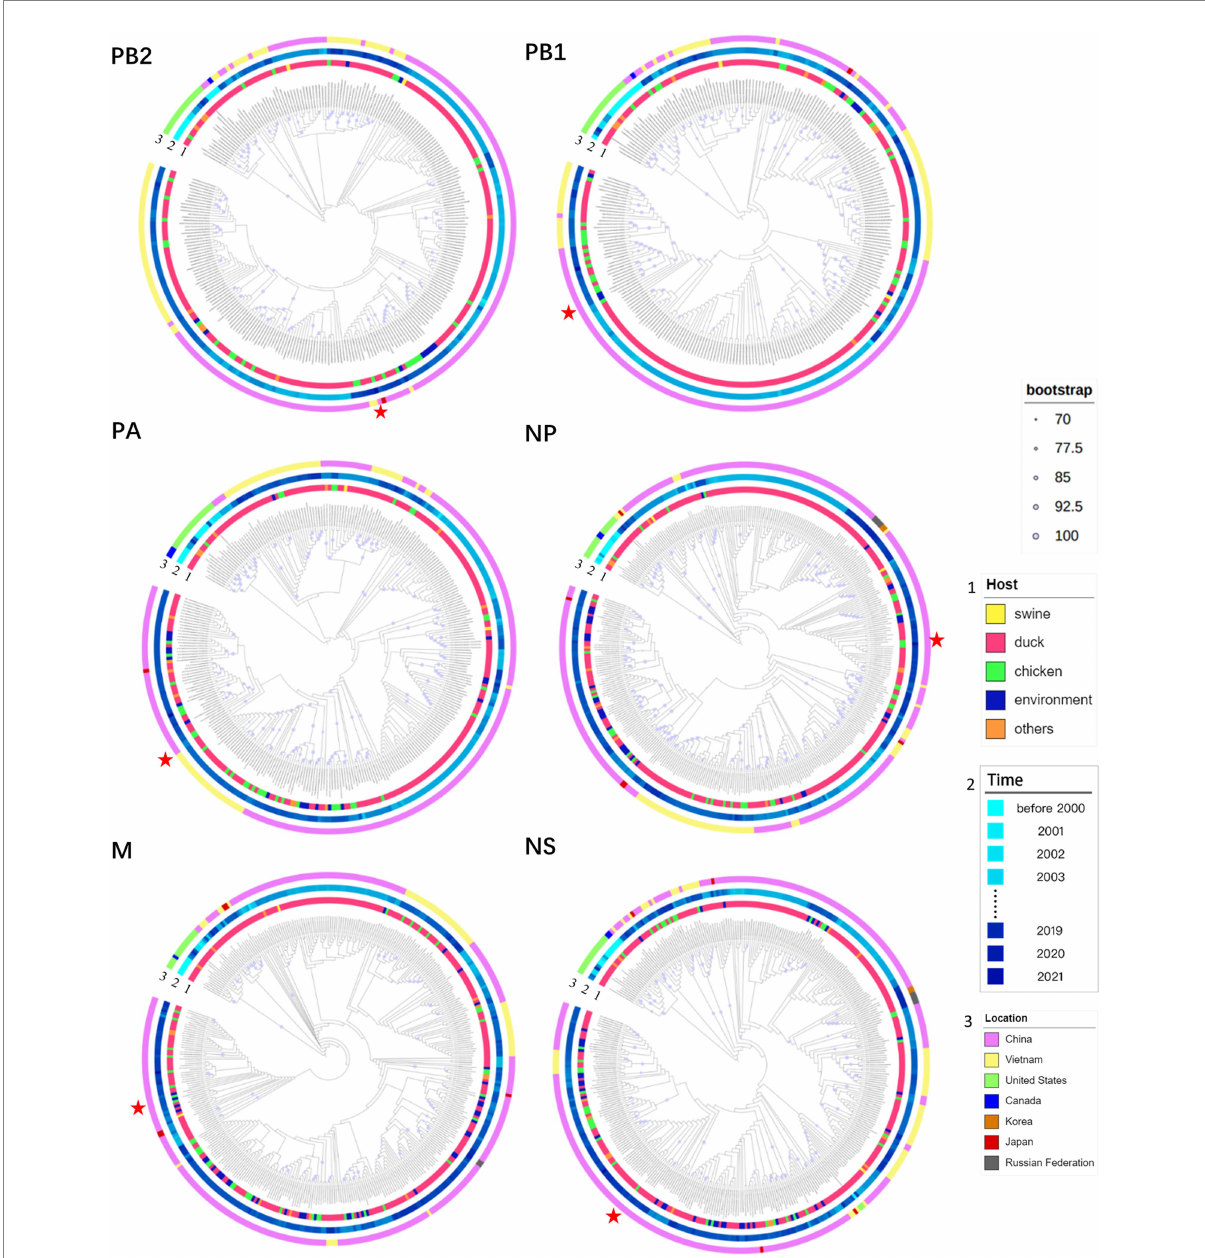
FIGURE 2 Phylogeny and groups of PB2, PB1, PA, NP, M, and NS of H6N6. Only bootstrap values ≥ 70% are indicated as a purple circle in the middle of the branch. The size of the circle is proportional to the bootstrap value. Categories of viruses (such as host, and location) are identified by different colors. ZJ49 is indicated by a red five-pointed